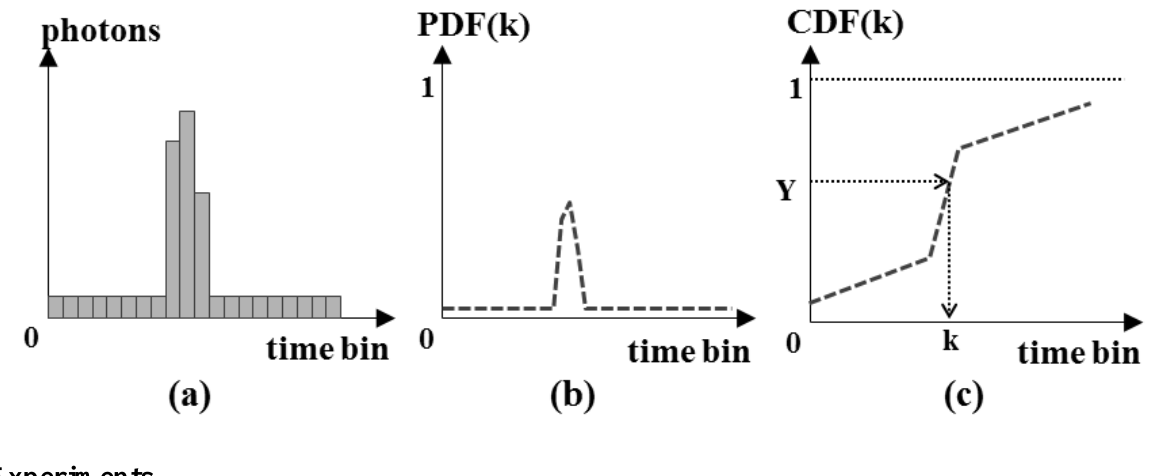
Figure 11. Simulation of the time at which the pixel detects the primary photon (( a ) photons; ( b ) probability density function; ( c ) cumulative distribution